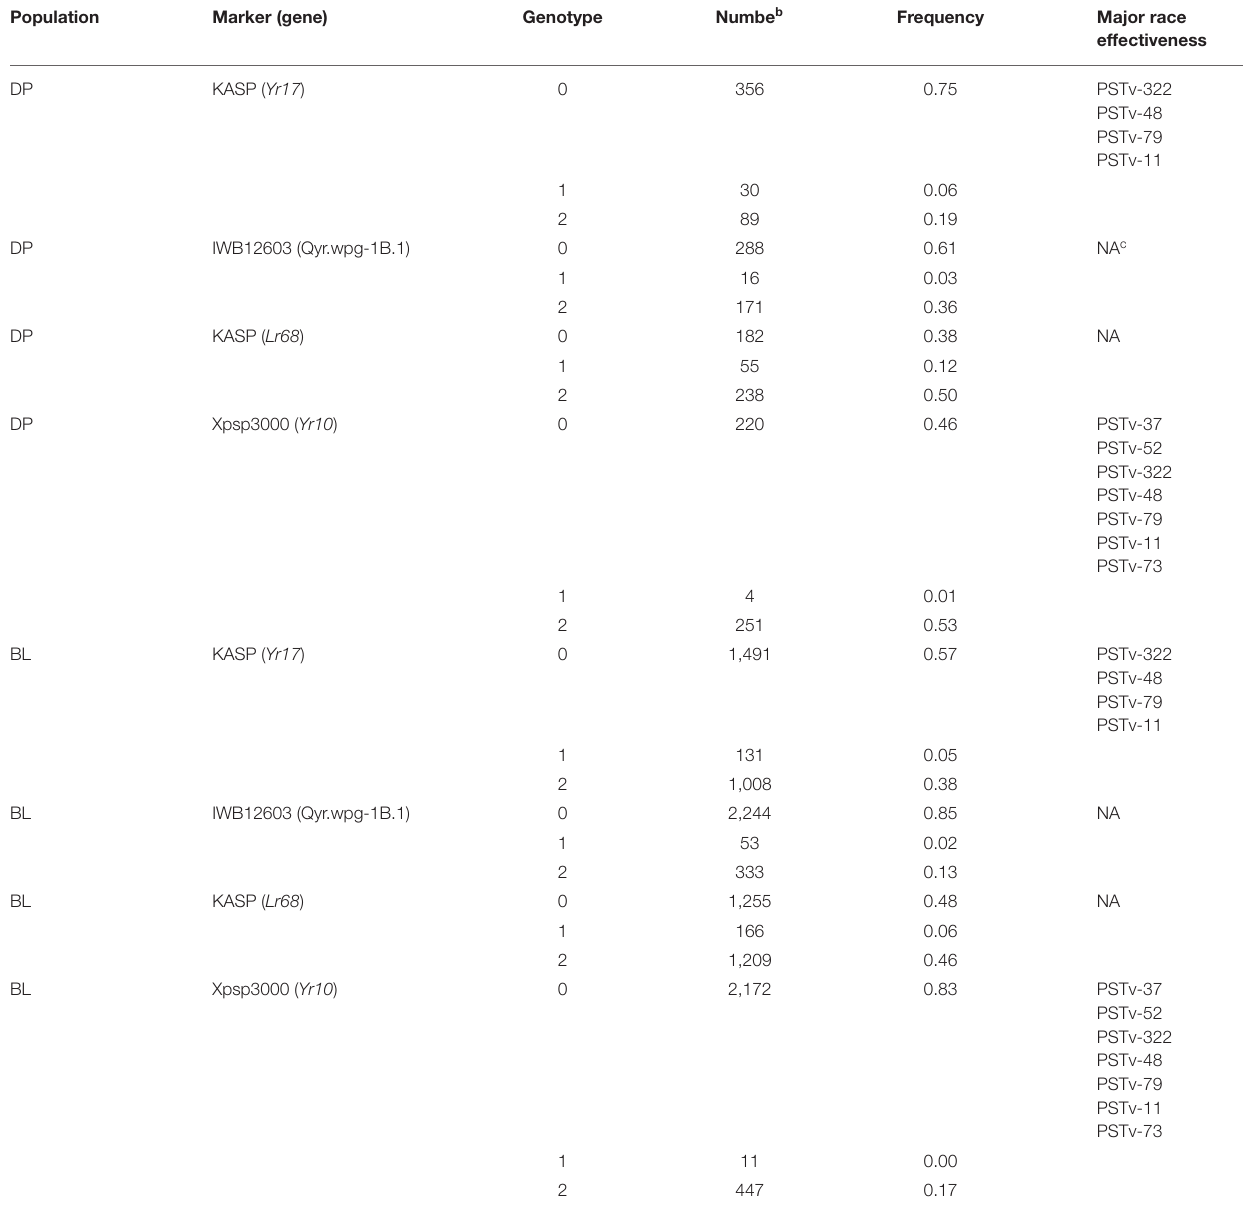
TABLE 4 | Frequency of rust-resistant genotypes a in both the breeding line (BL) and diversity panel (DP) line populations.